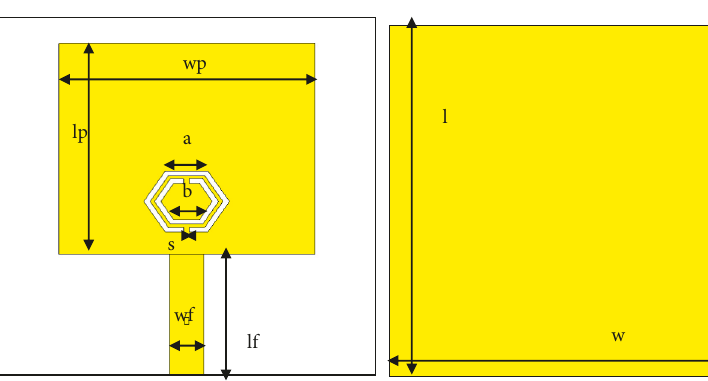
Figure 2: HCSRR rectangular printed antenna front and back view